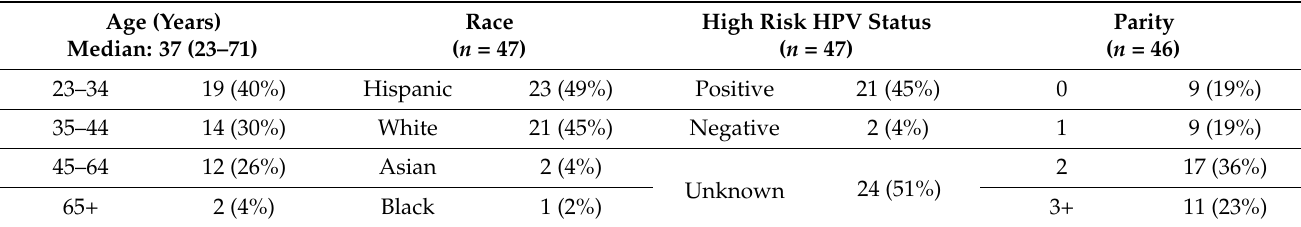
Table 1. Cohort demographics: age, race, high-risk HPV status and parity upon presentation for treatment. Age